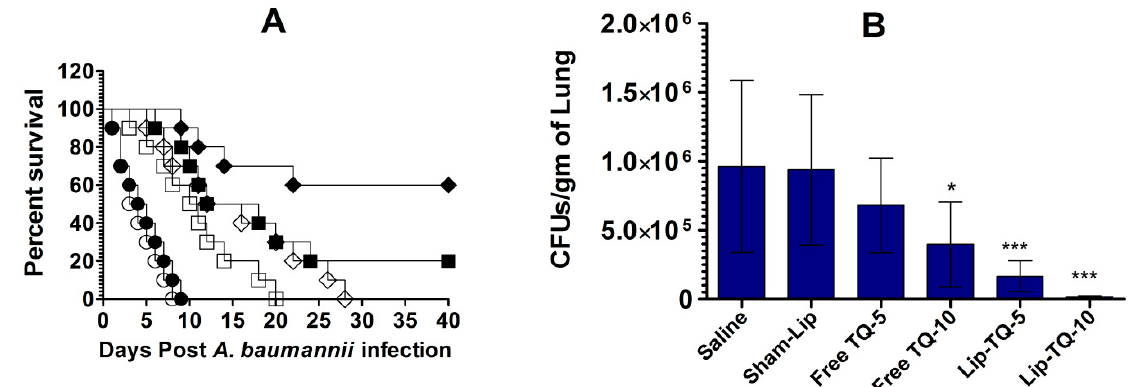
Figure 4. Treatment with Lip-TQ was highly effective against A. baumannii in the leukopenic mice. ( A ) Each mouse was intravenously infected with 1 × 10 6 CFUs of A. baumannii . After 24 h, the infected mice were treated with a single daily dose of free TQ or Lip-TQ (5 and 10 mg/kg) for 7 days. Saline ( ), Sham-Lip ( ), Free TQ-5 mg/kg ( ), Free TQ-10 mg/kg ( ), Lip-TQ-5 mg/kg ( ), Lip-TQ-10 mg/kg ( ). Saline vs. Free TQ-5 mg/kg ( p = 0.009), Sham-Lip vs. Lip-TQ-5 mg/kg ( p < 0.0001), Saline vs. Free TQ-10 mg/kg ( p = 0.0001), Sham-Lip vs. Lip-TQ-10 mg/kg ( p < 0.0001), Free TQ-10 mg/kg vs. Lip-TQ-10 mg/kg ( p = 0.0074). The survival data are presented by a Kaplan–Meier curve and analyzed by the Log-rank Chi square test. ( B ) On day 7 post-infection, 3 mice from each group were sacrificed and equally weighed pieces of the lung tissue were homogenized in sterile normal saline. After a proper dilution, the tissue homogenate was spread on the nutrient agar plates. The plates were incubated at 37 ◦ C for 24 h. The CFUs were counted, and the total numbers were calculated by multiplying the dilution factor. The data are represented as the mean ± SD of three independent values. * ( p < 0.05), *** ( p < 0.001). The data were analyzed by one-way ANOVA followed by the Turkey post-test.